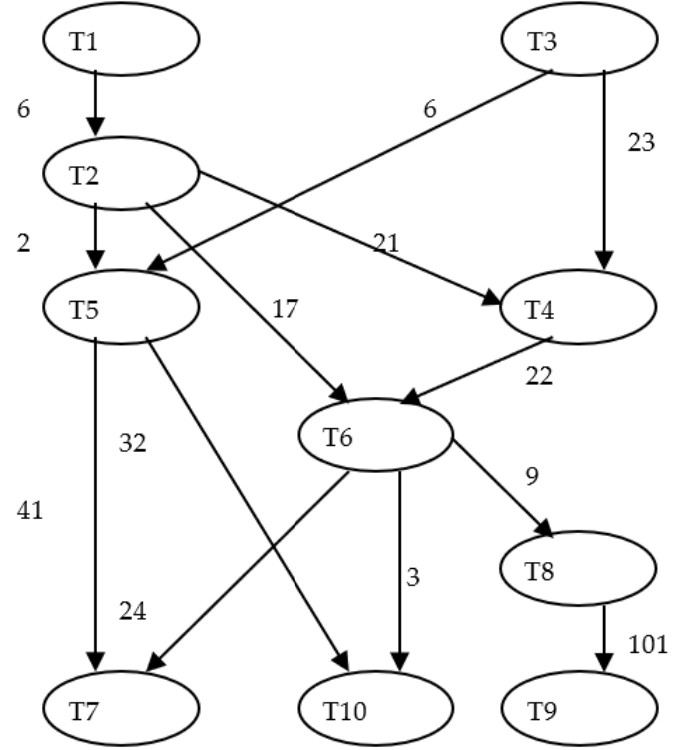
Figure 3. A model DAG with 10 tasks. Table 2. Probable execution cost (PEC)